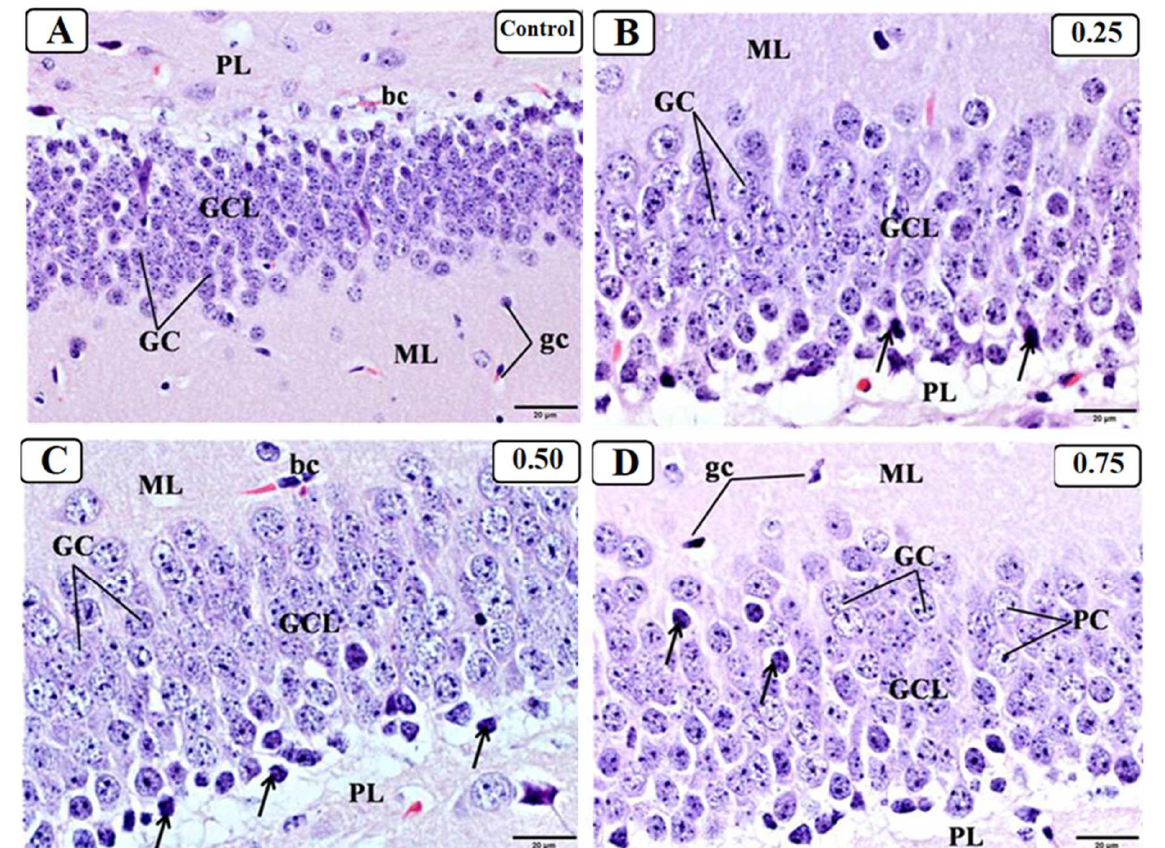
Figure 8. Representative photomicrographs of the dentate gyrus (DG) region. ( A ) The control group displaying three layers: the molecular layer (ML), granule cell layer (GCL), and polymorphic layer (PL). The GCL exhibits aggregation of rounded to oval granule cells (GC). ( B ) Nearly normal appearance in LPS 0.25 treated group, except the presence of some degenerated GC (arrow). ( C ) Many degenerated GC in the GCL in LPS 0.5 treated group, which appeared condensed with pyknotic nuclei (arrow). ( D ) Many degenerated GC (arrow) in the GCL in LPS 0.75 treated group, which appeared condensed with pyknotic nuclei. (H&E × 400).